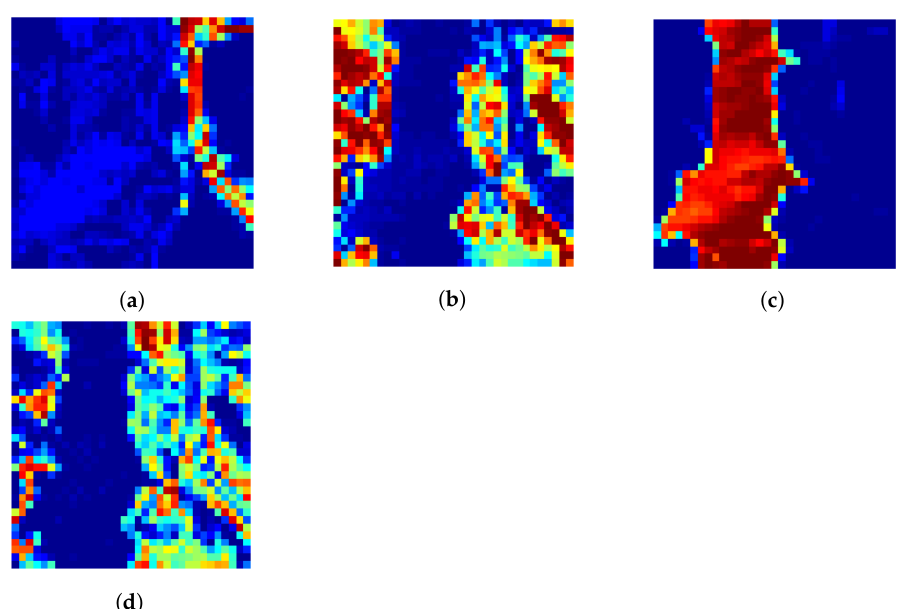
Figure 6. Abundances maps of Jasper ridge hyperspectral image: ( a ) road, ( b ) tree, ( c ) water, and ( d ) soil. Table 1. Confusion matrix of SMKSVD-TV: Jasper ridge hyperspectral image. Predicted Classes Road Tree Water Soil Road 3090